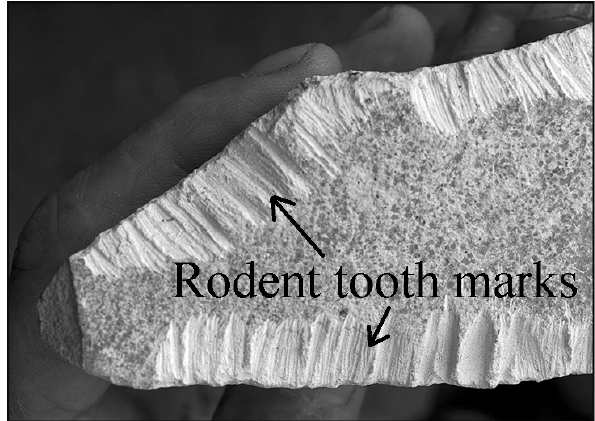
Figure 2. Rodent tooth marks on a dense zeolitic rhyolite tuff. Sam- ple from a kudur in the Chetvertyi stream basin (the Solontsovsky palaeovolcano